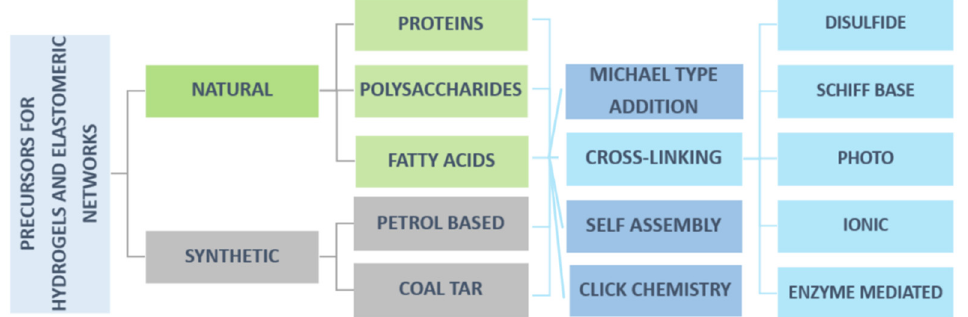
Figure 4. Natural and synthetic precursors of elastomers and hydrogels by their origin, reaction type and crosslinking method.